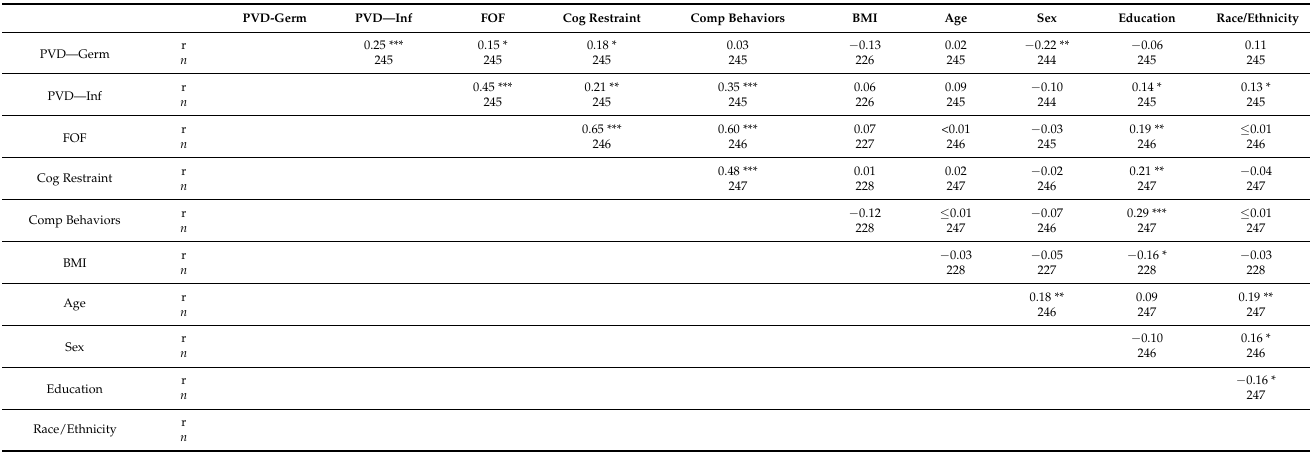
Table A1. Correlation matrix with potential